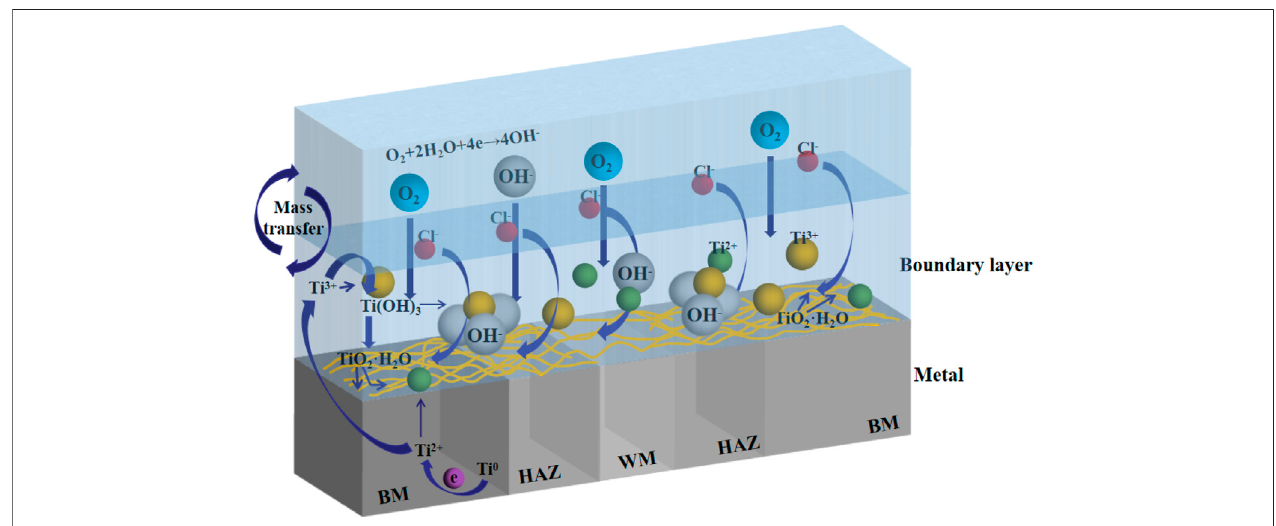
FIGURE 13 | Simulated corrosion process of TA2 welded joint in